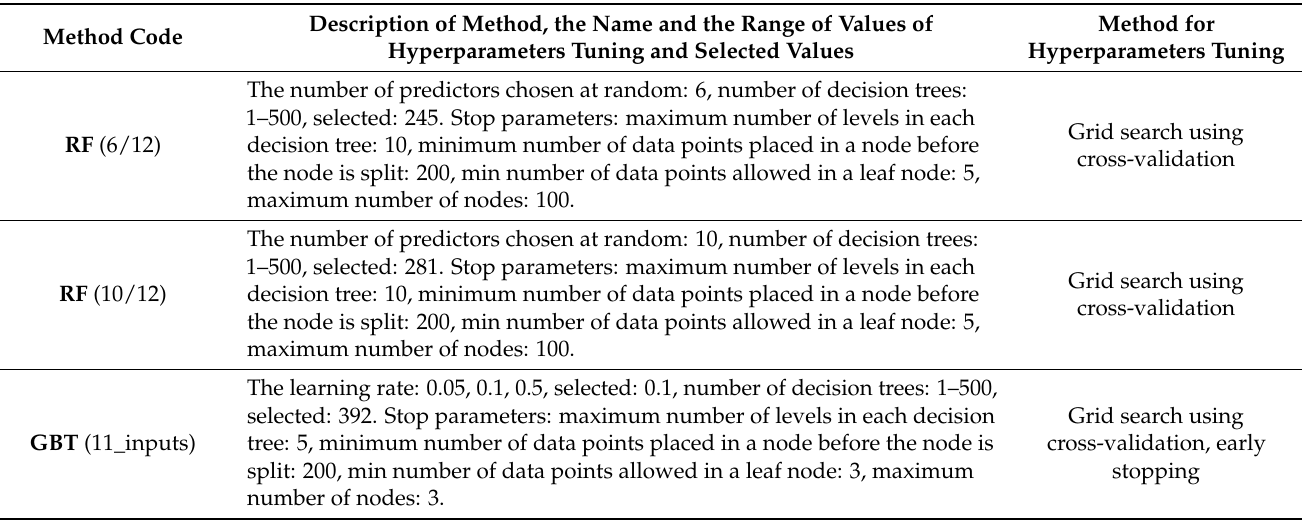
Table A4. Results of hyperparameter tuning for the proposed ensemble methods for time series No. 2. Method